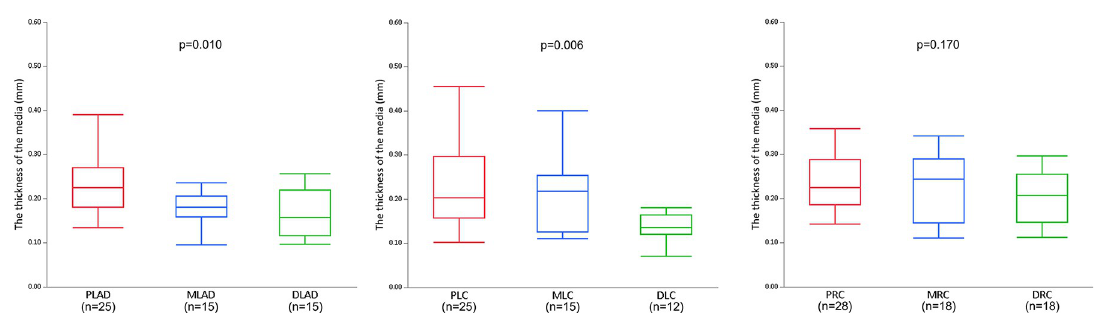
Fig 2. The comparison of the medial thicknesses between proximal, mid, and distal segments of LAD, LCX, and RCA. A. The medial thickness of the main branch of LAD became lower from proximal to distal segments (p = 0.010). B. The medial thickness of the main branch of LCX became lower from proximal to distal segments (p = 0.006). C. The medial thickness of the main branch of RCA did not significantly become lower from the proximal to distal segments (p = 0.170). LAD, left anterior descending artery; PLAD, proximal LAD; MLAD, mid LAD; DLAD, distal LAD. LCX, left circumflex artery; PLC, proximal LCX; MLC, mid LCX; DLC, distal LCX. RCA, right coronary artery; PRC, proximal RCA; MRC, mid RCA; DRC, distal RCA.